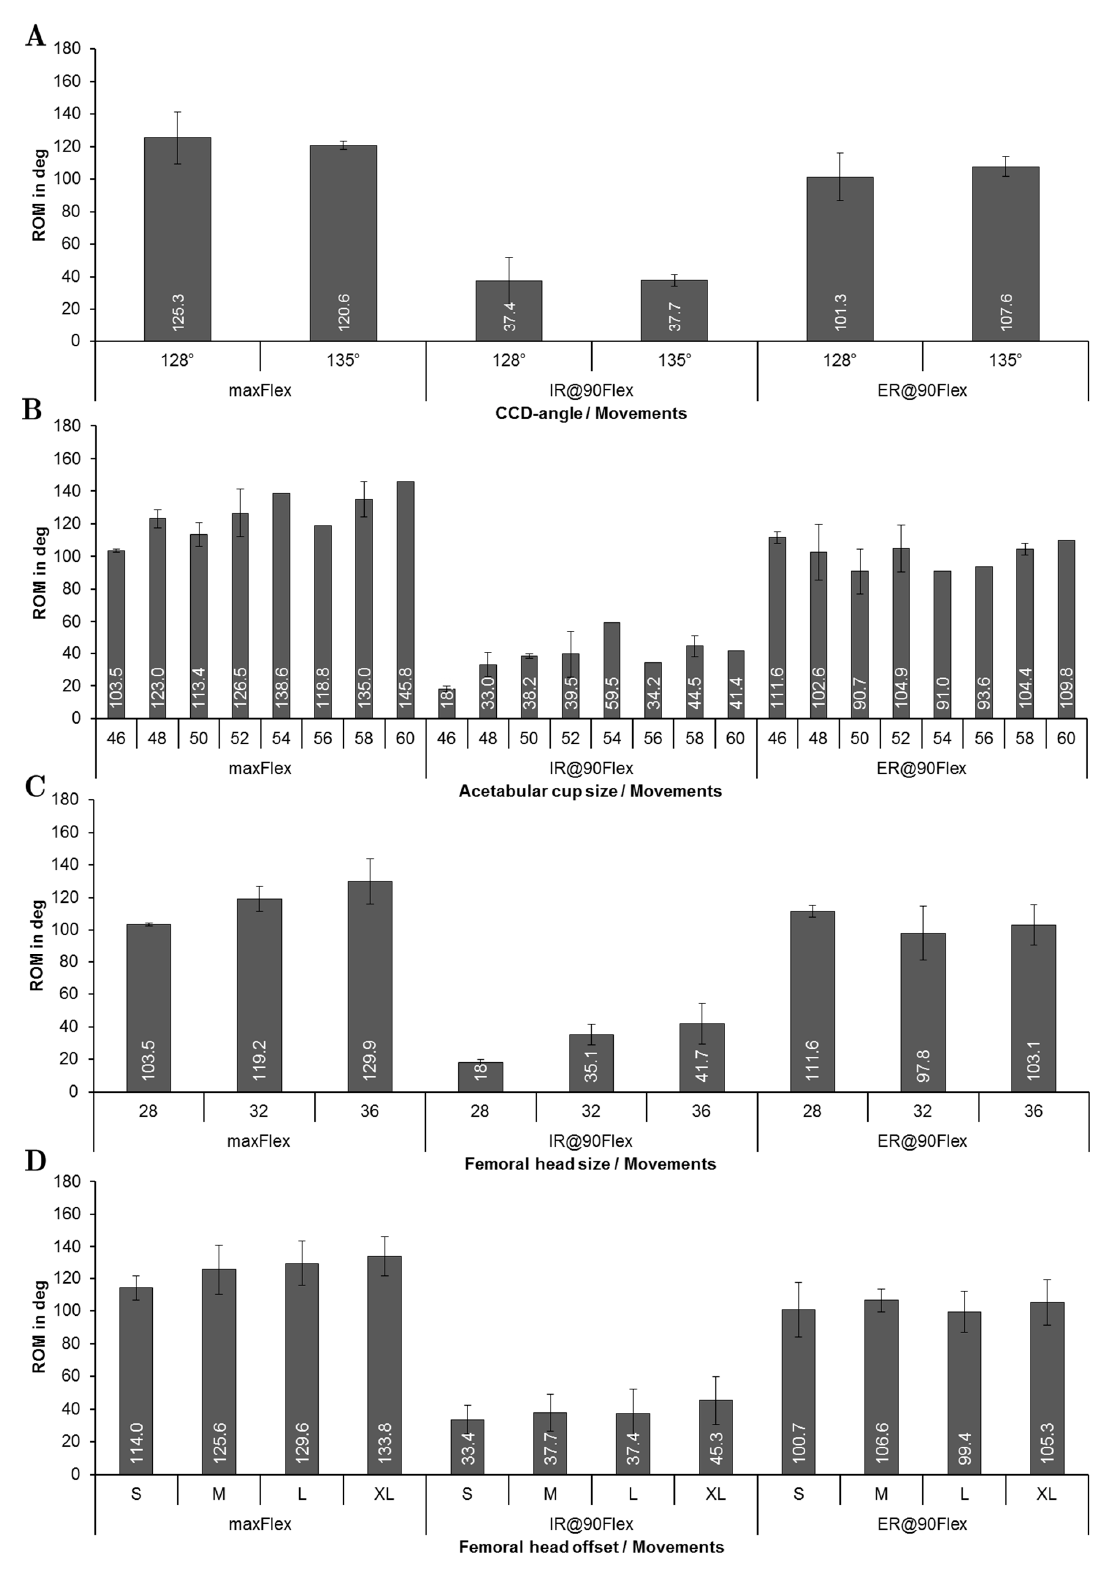
Figure 6. Results of the ROM analysis depending on implant-specific design parameters during maximum flexion (maxFlex), internal rotation at 90° flexion (IR@90Flex), and external rotation at 90° flexion (ER@90Flex): ( A ) CCD-angle; ( B ) acetabular cup size; ( C ) prosthetic head size; ( D ) prosthetic head offset.